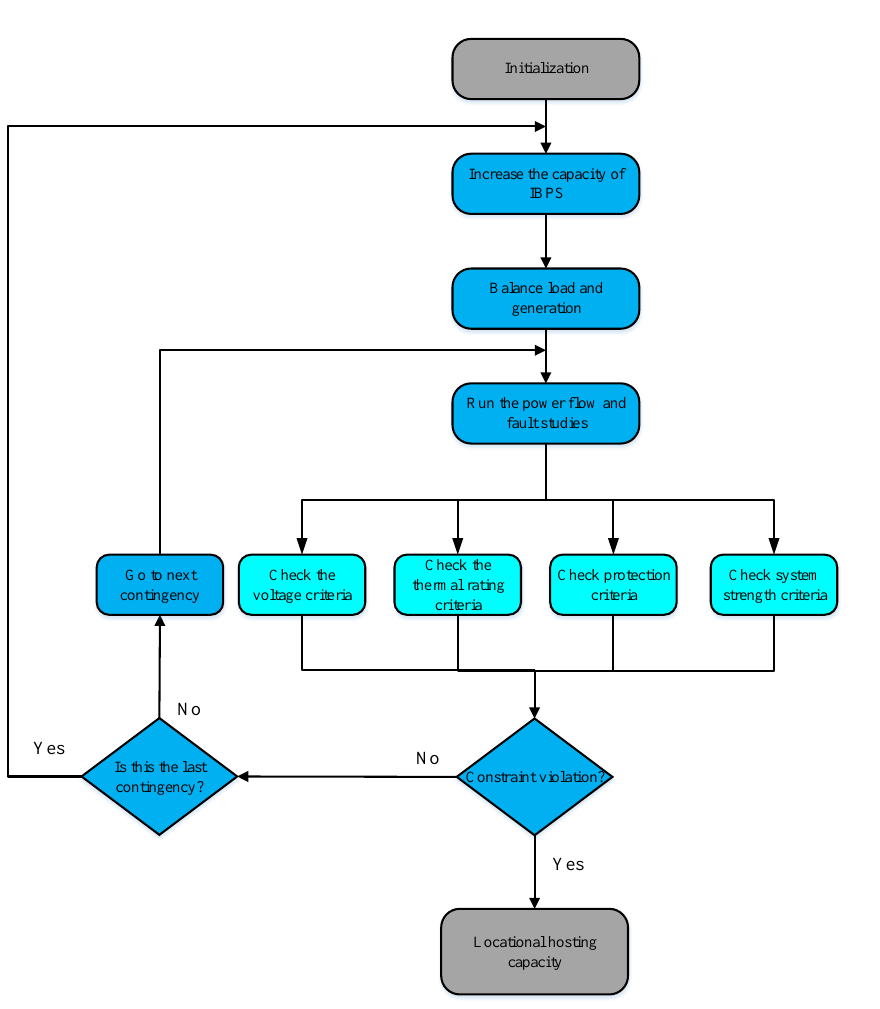
Figure 2. Methodology for identifying the locational HC of grid-following